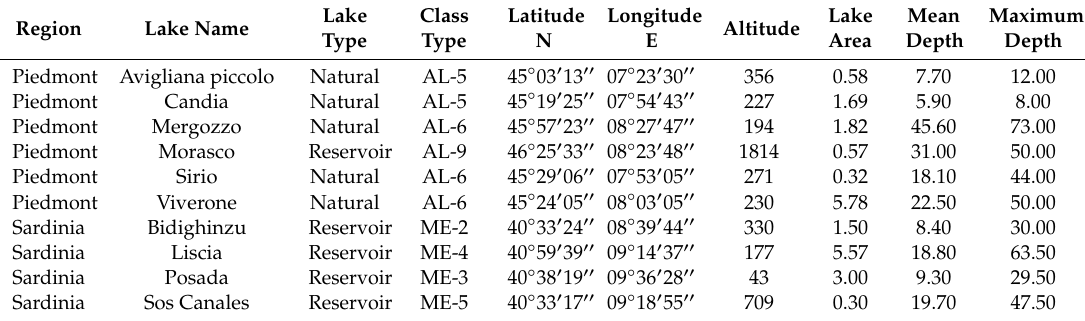
Figure 1. Distribution of considered administrative regions and sampled lakes in Italy. Table 1. Administrative regions, lake names and types, ecoregions (AL = Alpine, ME = Mediterranean) and class types of lakes, and their respective main geographic and morphological information. Latitude and longitude, in WGS84 system, are expressed as DMS (Degrees, Minutes, Seconds); Altitude: m a.s.l.; Lake area: km²; Mean and Maximum depth: m.